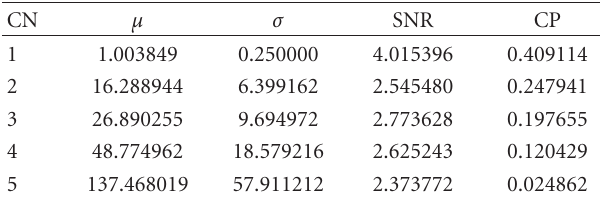
Table 3: Statistical information about the best class number for the simulated phantom data set, tumour 1.